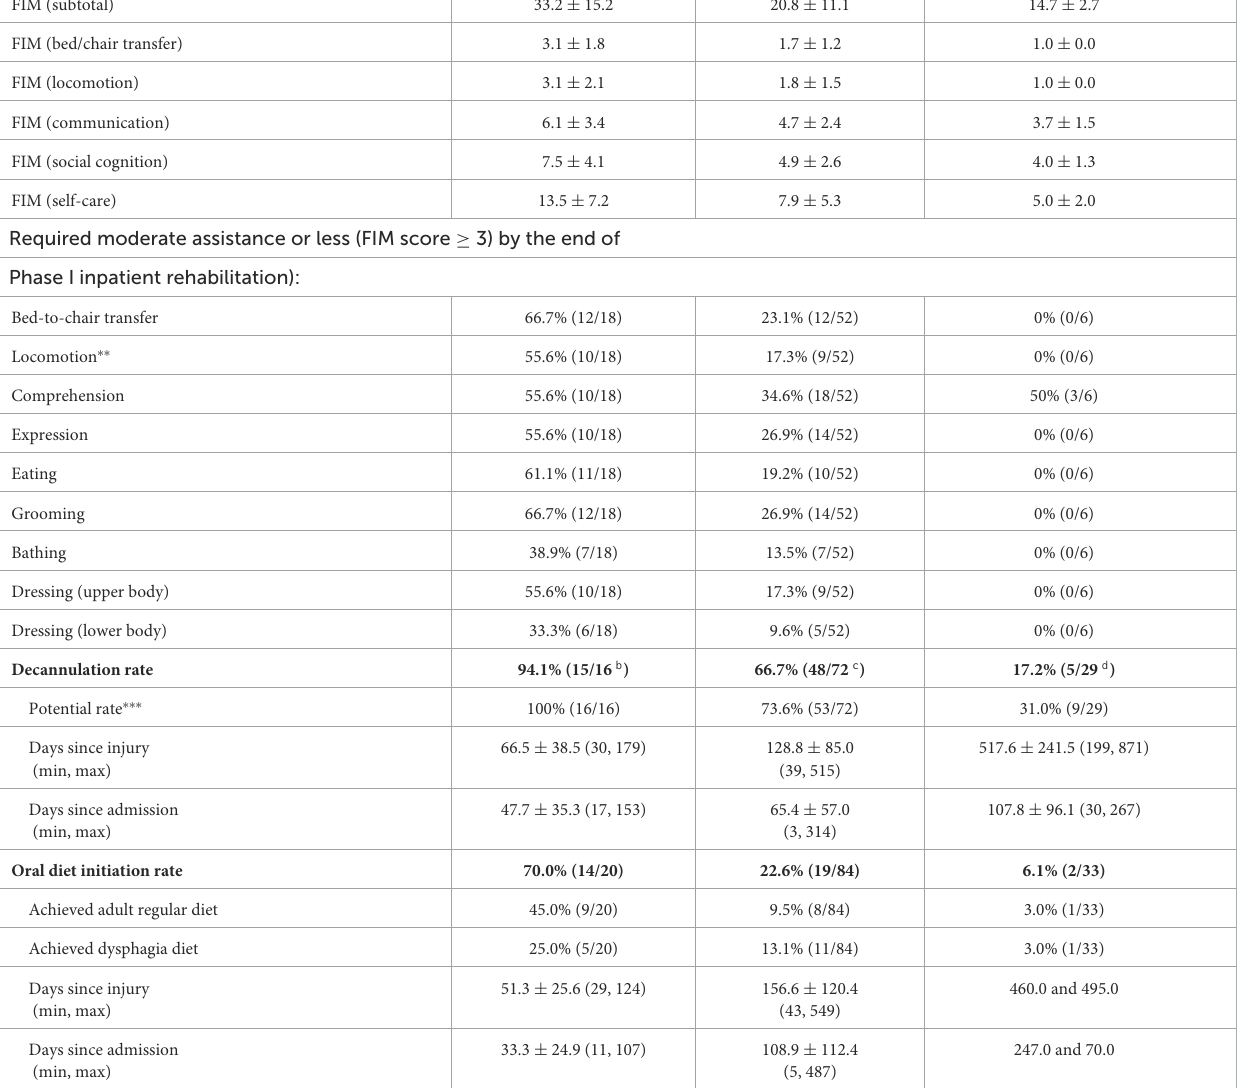
TABLE 2 Functional recovery among patients with DoC admitted at different stages post-injury. Acute ( N = 20) Subacute ( N = 84) Chronic ( N = 33) Emergence rate 90.0% (18/20 a ) 61.9% (52/84) 18.2% (6/33) Among emerged patients (by the time of discharge